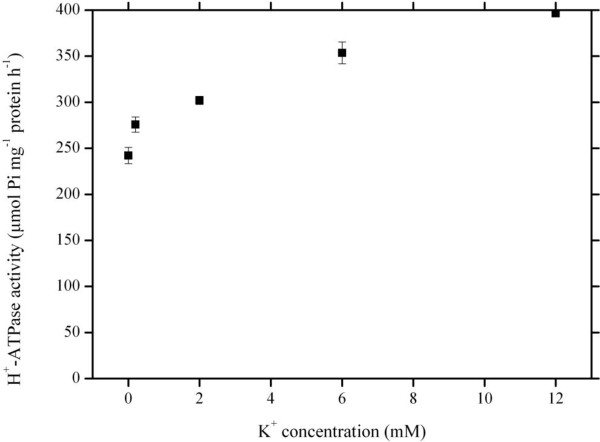
K+-dependent plasma membrane H+-ATPase activity. Phenanthrene concentration was 5.62 μM. K+ varied from 0 to 12 mM. Data points represent mean and SD values of triplicates. Error bars do not extend outside all data points. Pi, inorganic P.